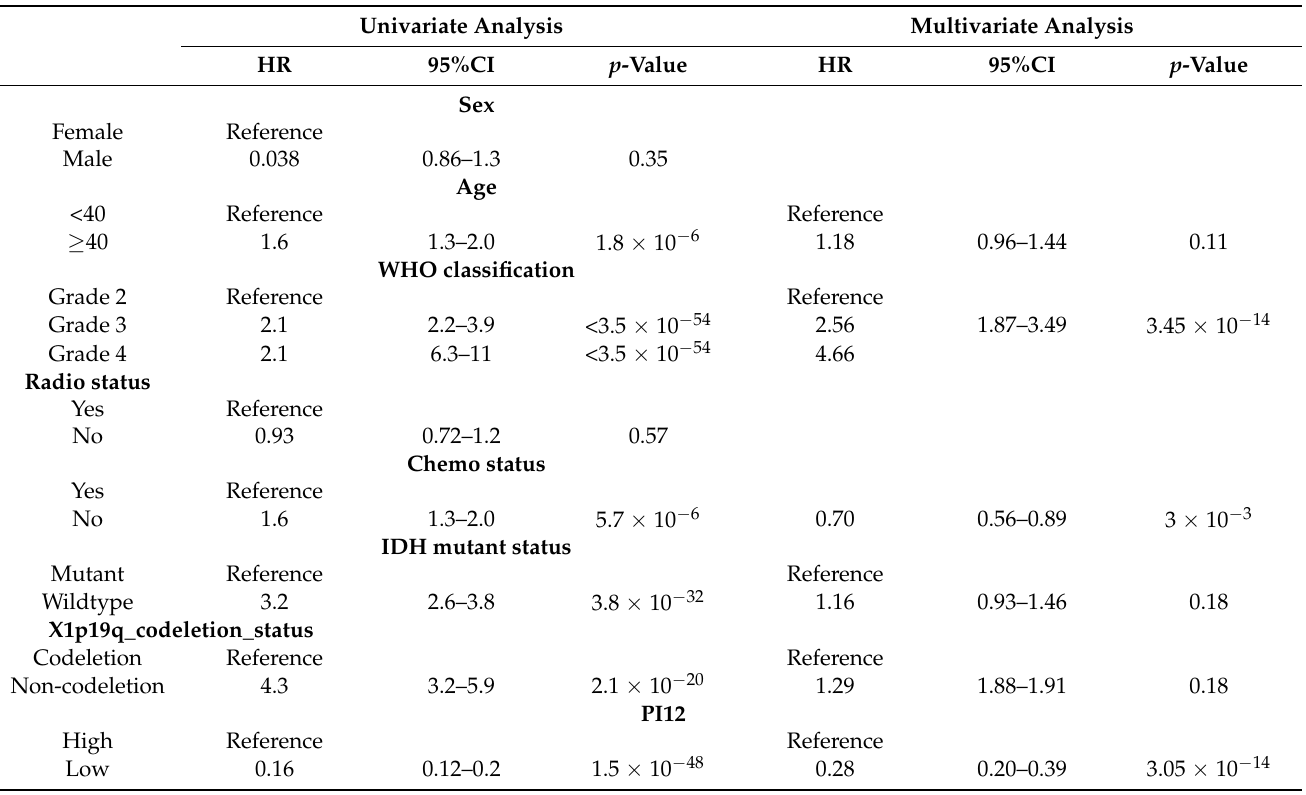
Table 3. Univariate analysis and multivariate analysis of the training cohort. Univariate